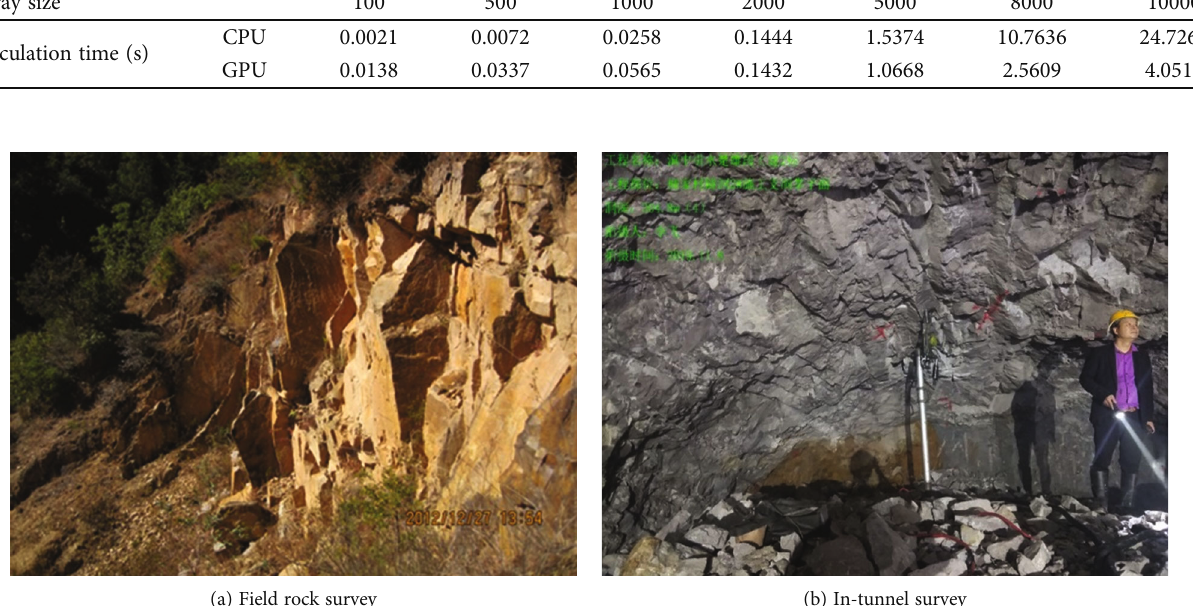
Figure 3: No mudstone-type stratigraphic